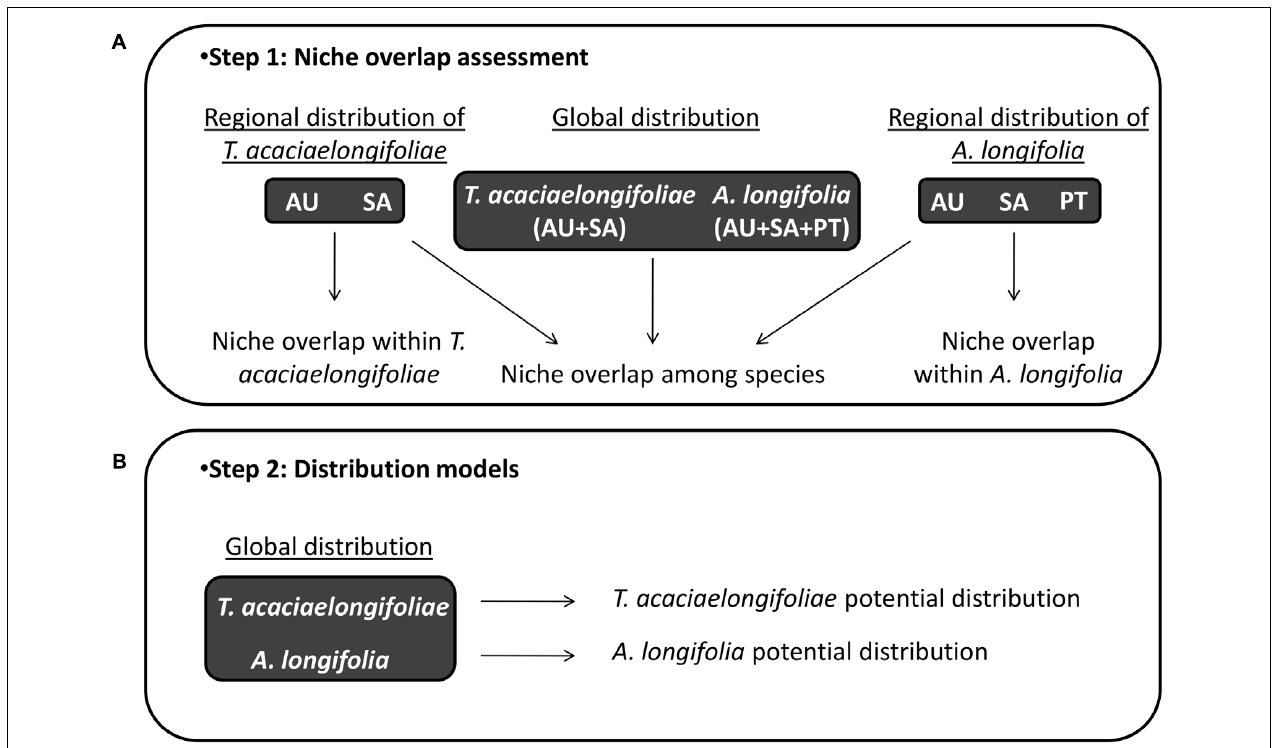
FIGURE 2 | Workflow for niche overlap assessments and distribution modeling. Panel (A ; top): Regional species distribution datasets were compared to assess niche conservatism for Acacia longifolia and Trichilogaster acaciaelongifoliae. Niche overlap among species was quantified (overlap), tested (equivalency and similarity), and characterized (stability, expansion, and unfilling) to assess ecological overlap in environmental space. Panel (B ; bottom): Distribution modeling was used to project ecological overlap into geographic space and predict the potential ability of T. acaciaelongifoliae to establish in areas susceptible to A. longifolia invasion in the Mediterranean basin. Acronyms: AU: Australia, SA: South Africa, and PT: